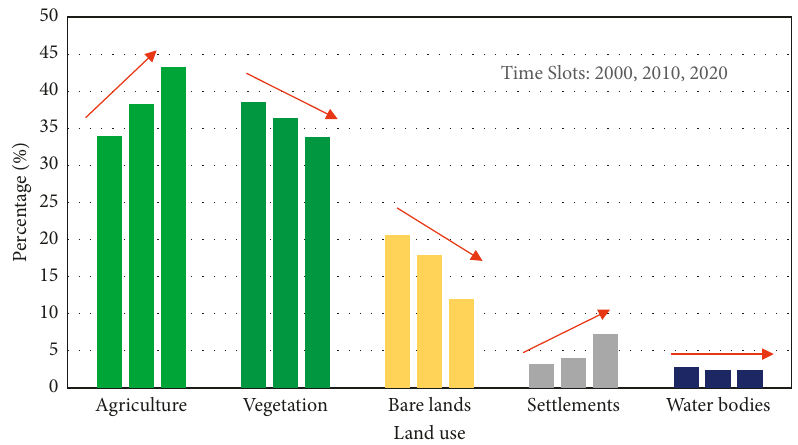
Figure 5: Land use and land cover change statistics of Sri